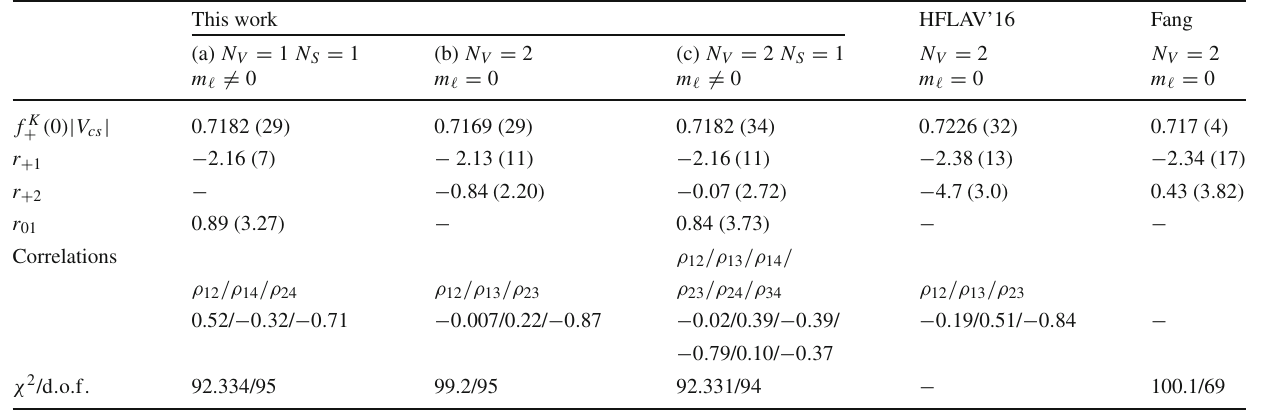
Table 7 The extracted values of the parameters f K + ( 0 ) | V cs | , r + 1 , r + 2 and r 01 and the correlation coefficients between them ρ ij in the fittings where i and j with the values from 1 to 4 correspond to the four param- eters. r + 1 and r + 2 are the shape parameters of f + ( q 2 ) , and r 01 is of